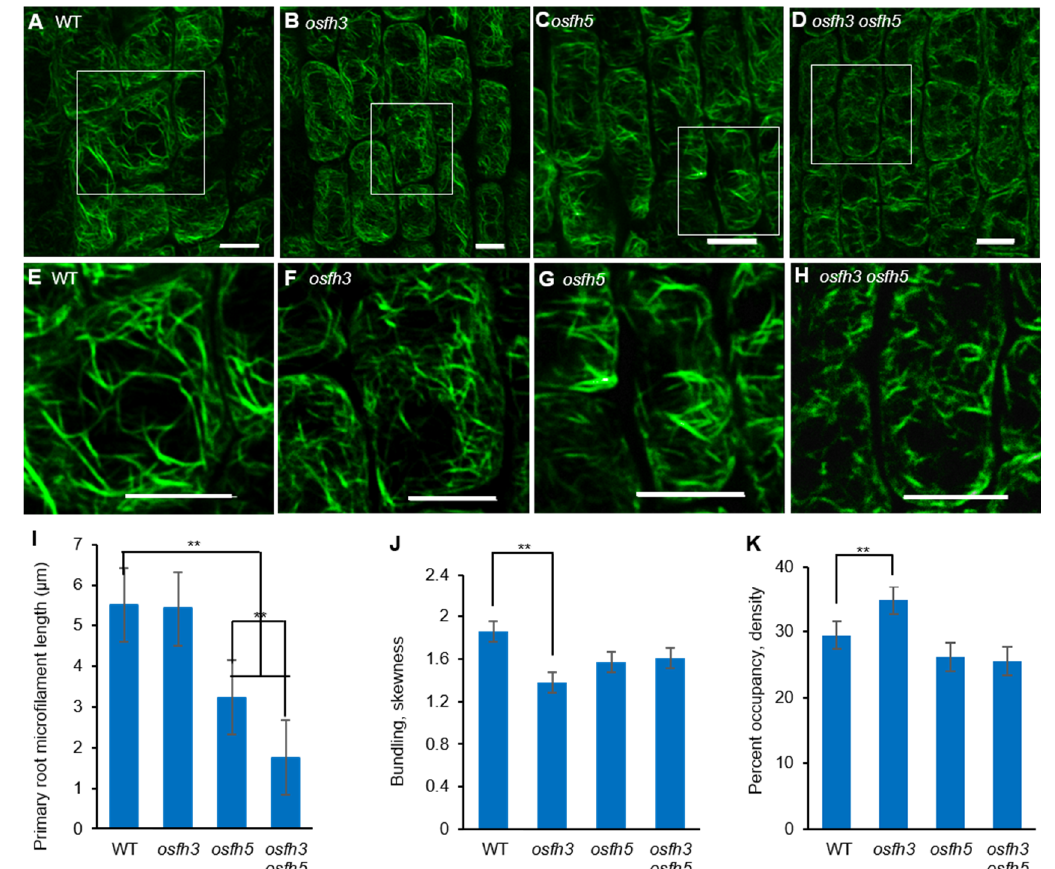
Figure 3. Microfilaments staining results with Alexa Fluor 488 ® -phalloidin. ( A – D ) Alexa Fluor 488 ® -phalloidin stained lateral root elongation zone of 3-day-old rice seedlings. Bar = 10 µ m. ( E – H ) Enlarged pictures of white boxes in A to D, respectively. Bar = 10 µm. ( I ) Length of microfilaments in primary roots. Mean ± SD, n > 100 microfilaments from 10 cells across 5 plants. ** p < 0.001, one-way ANOVA. ( J ) Bundling (skewness) of 3-day-old seedling roots. Mean ± SD, n = 25 cells across 5 plants. ** p < 0.001, one-way ANOVA. ( K ) Percentage of occupancy (Actin filament abundance) of 3-day-old seedling roots. Mean ± SD, n = 25 cells across 5 plants. ** p < 0.001, one-way ANOVA. Region selection was divided by cells of pictures from elongation zone and quantified with ImageJ.